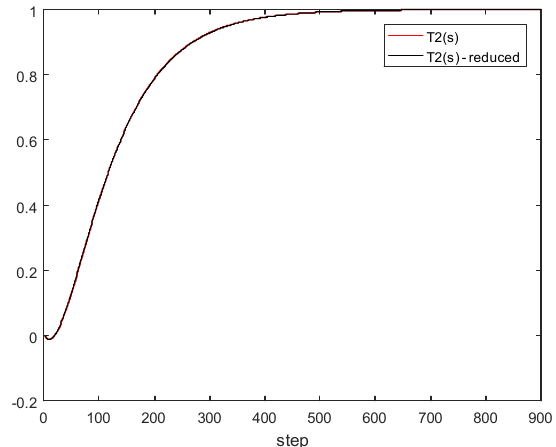
Figure 11. Comparison of original and T 2 and after order reduction (black line)—simulation of 900 time-steps.